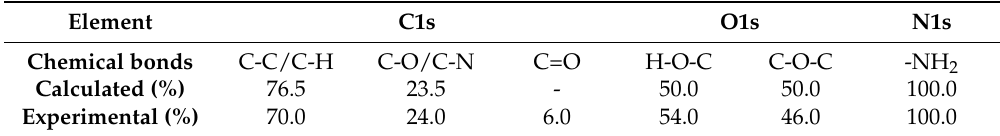
Table 2. Comparison between the calculated and the experimental proportion of the chemical bonds obtained from the fitting of C1s, O1s, and N1s XPS peaks.